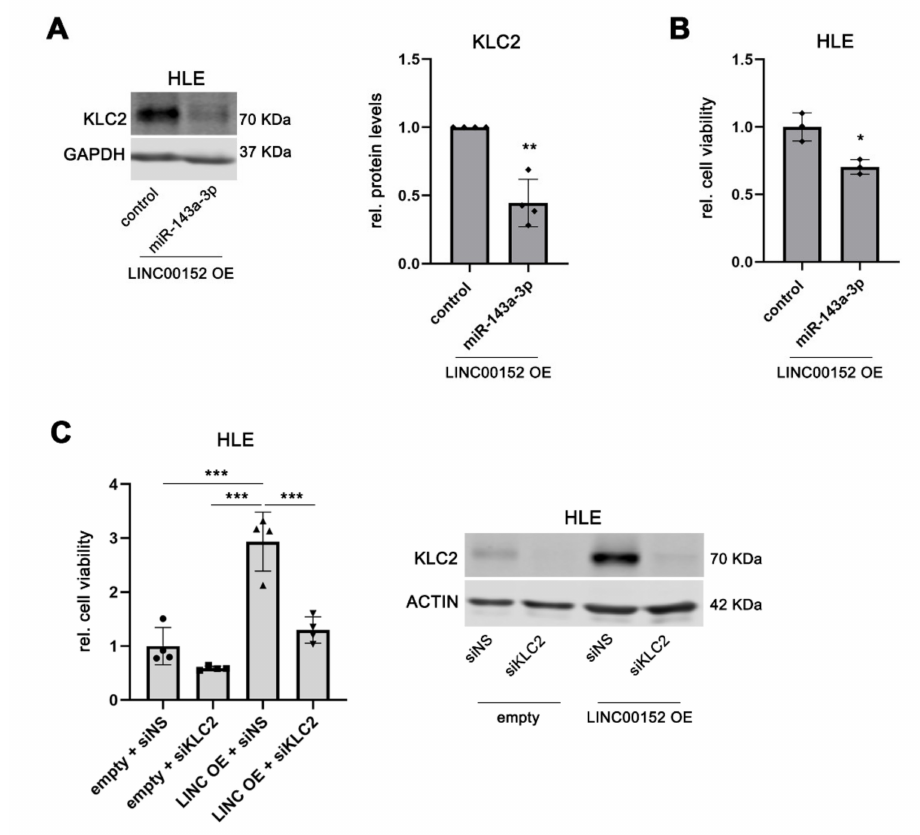
Figure 7. Mir-143a-3p mediates the KLC2 executed oncogenic phenotype of the LINC00152 ceRNA network. ( A ) Reduced KLC2 protein levels following miR-143a-3p mimic transfection compared to control in LINC00152 overexpressing cells. ( B ) MiR-143a-3p overexpression decreased cell viability of HLE cells overexpressing LINC00152 . ( C ) KLC2 knockdown reduced cell viability of LINC00152 - overexpressing HLE cells. Data are presented as mean ± SD of at least 3 biological replicates. Welch’s t -test in ( A ), unpaired t -test in ( B ) and one-way ANOVA followed by Tukey test in panel ( C ): * p < 0.05, ** p < 0.01, *** p < 0.001. Abbreviations: siNS, scrambled, nonsense siRNA; siKLC2, siRNA specifically targeting KLC2; LINC00152 OE or LINC OE, LINC00152 overexpression; OE, overexpression; empty, empty vector; rel.,